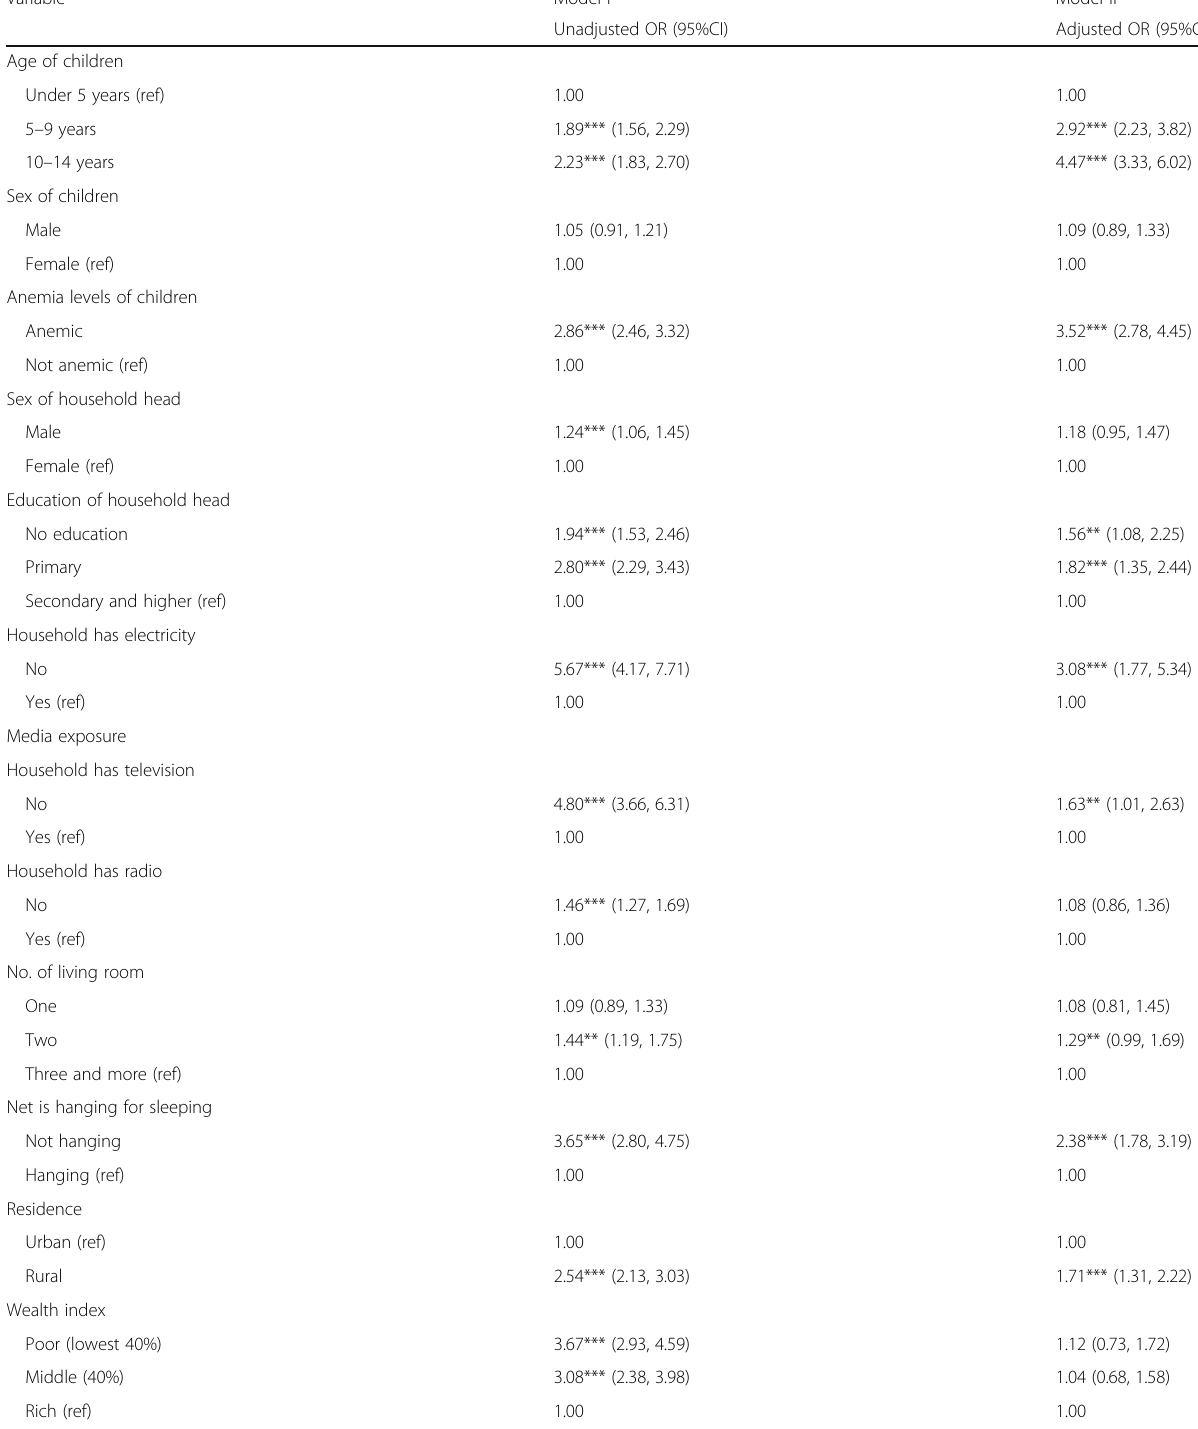
Table 3 Multivariable logistic regression model on sociodemographic determinants of